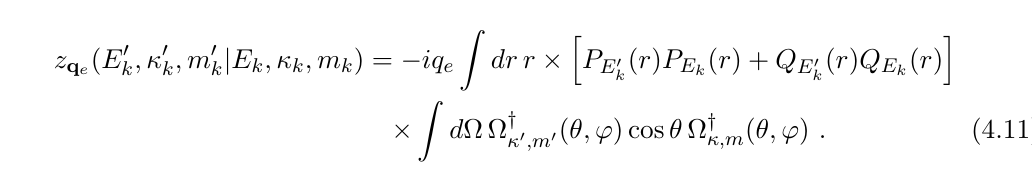
Table 1 . The number of electrons in a shell for the ground state con(cid:12)gurations. At this order, electron transitions are allowed only when the orbital angular momenta of o 0 and o di(cid:11)er by one, i.e. j ‘ 0 (cid:0) ‘ j = 1. Thus, the transition amplitude is reduced to k k k k